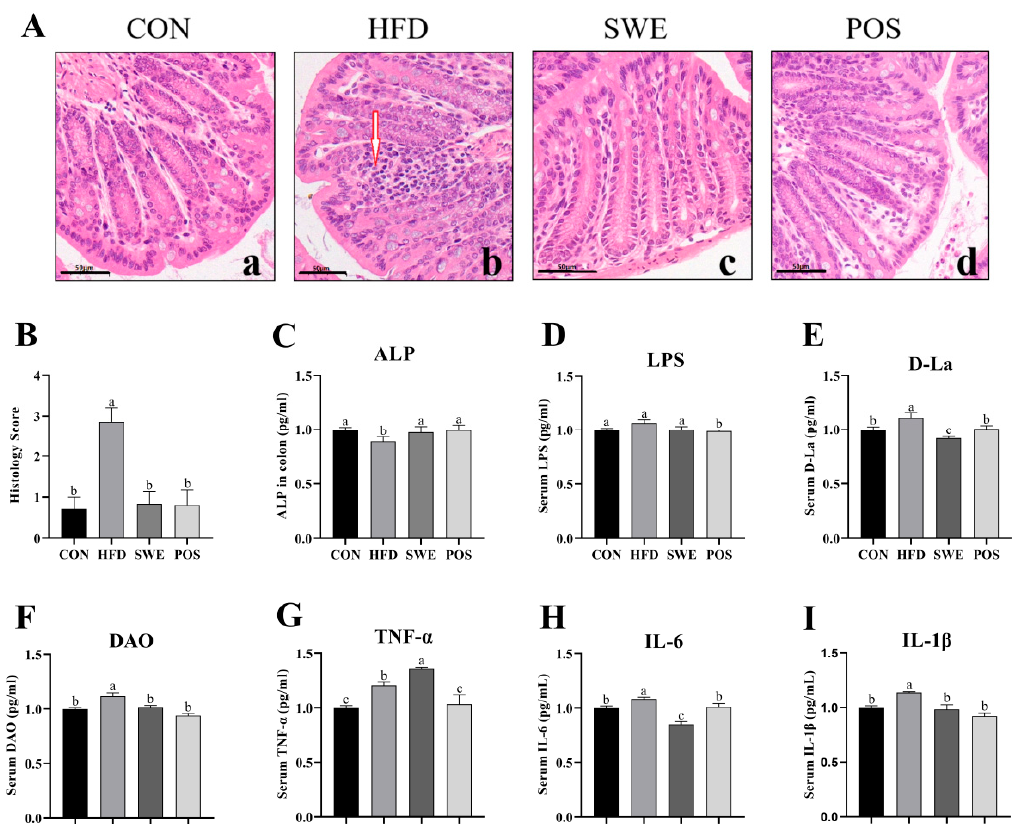
Figure 2. Effects of SWE on colonic mucosal morphology, intestinal permeability, and inflammation. ( A ) representative photographs of the distal colon sections with H&E staining (400 × ). Scale bar: 50 µ m; red arrow indicates inflammatory infiltration. The a, b, c, d in subgraph A represent the order of the pictures for easy elaboration, ( B ) Histological score of the colon tissues (n = 5–7), ( C ) ALP level in colon, ( D ) LPS level, ( E ) D-La level, ( F ) DAO level, ( G ) serum TNF- α level. ( H ) serum IL-6 level, ( I ) serum IL-1 β level. Values are expressed as mean ± S.E.M. Data with different superscript letters are significantly different ( p < 0.05). n = 4–8 per group.